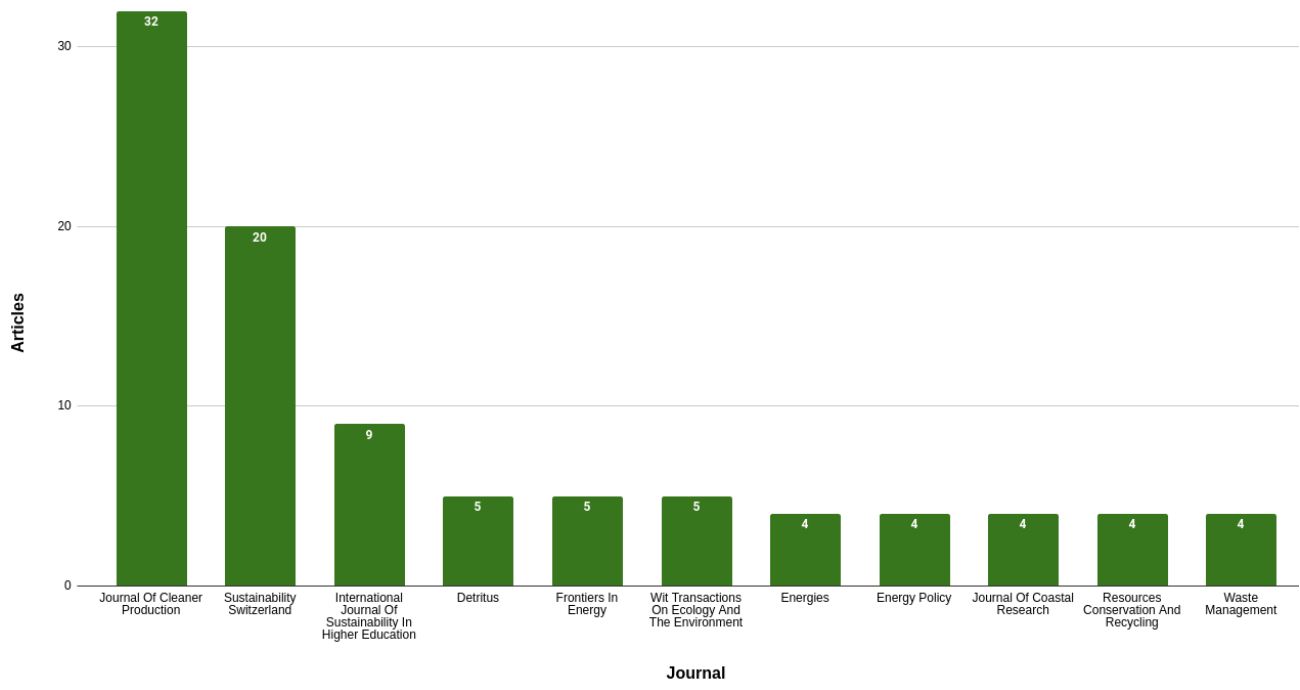
Figure 2. Relevant Scopus-indexed journals in the areas of education, CE (circular economy), and sustainable